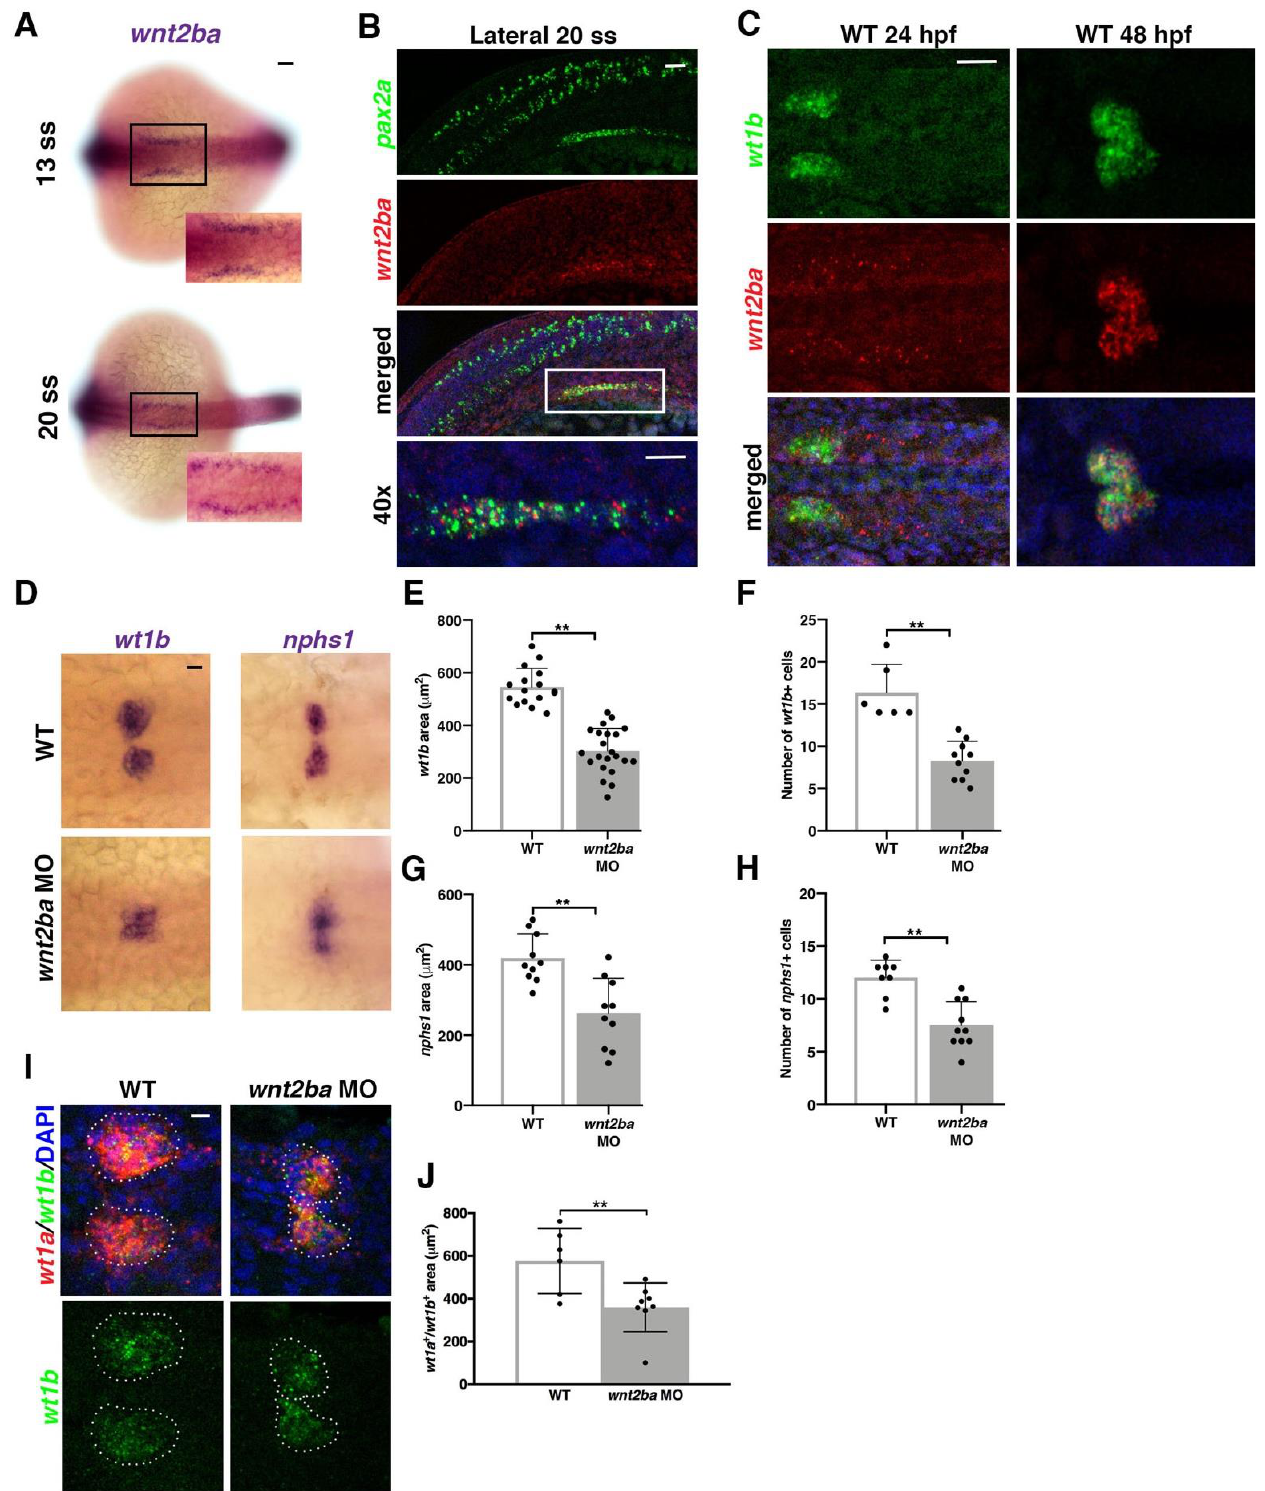
Figure 4. wnt2ba is a podocyte marker and regulator. ( A ) wnt2ba is expressed in bilateral stripes as early as 13 ss. Scale bar is 30 μm. ( B ) wnt2ba (red) is expressed within the anteriormost region of the IM, as shown by colocalization with pax2a (green). White box denotes area of colocalization, which is magnified in bottom panel. DAPI (blue) marks nuclei. Scale bar is 15 μm. ( C ) wnt2ba (red) also colocalized with the podocyte marker wt1b at 24 hpf, though at this time point it was also expressed in the putative neck segment domain. By 48 hpf, the wnt2ba domain was specified to the podocytes.